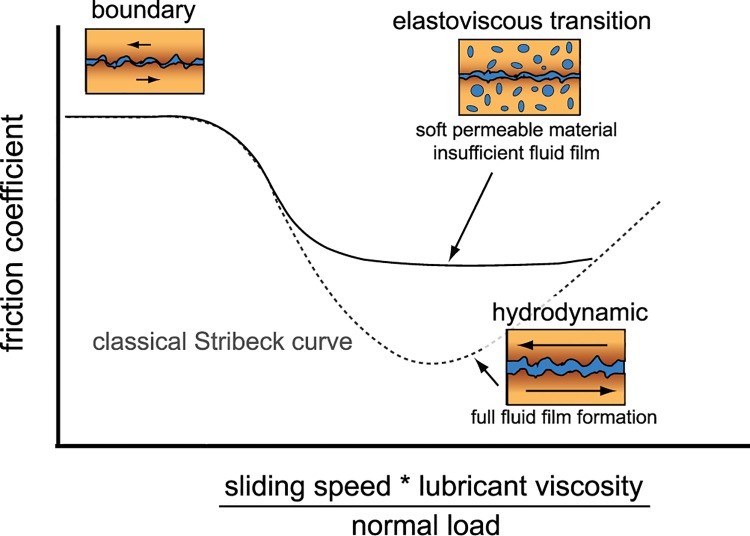
A classical Stribeck curve (dotted line) maps the transition of friction from high (boundary) friction to low (hydrodynamic) friction.For soft, permeable contacts like articular cartilage, a divergence from the classical curve is described by an elastoviscous transition [26] where contact compliance and permeability hinder the transition to hydrodynamic lubrication.